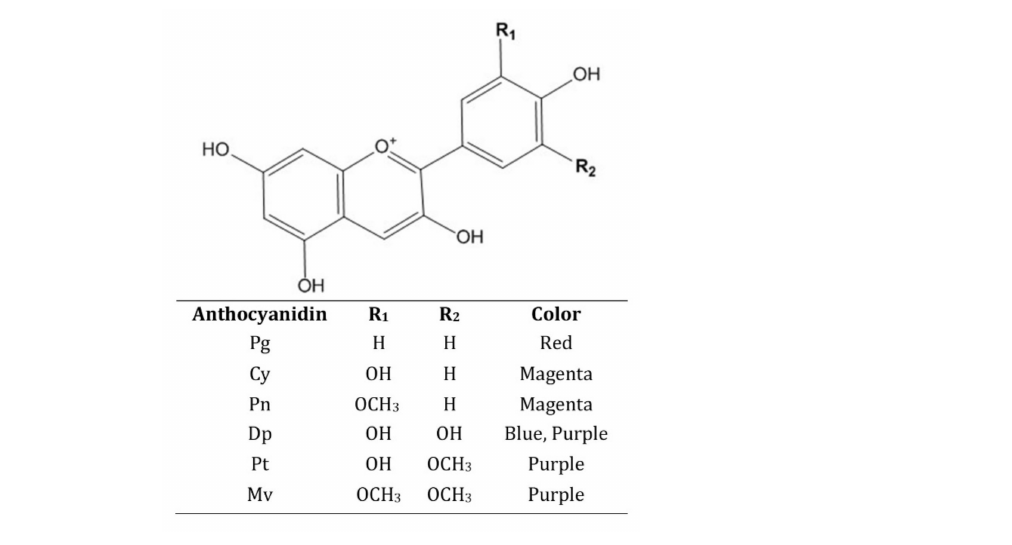
Figure 1. Chemical structures of the most common anthocyanidins and their color range in the visible